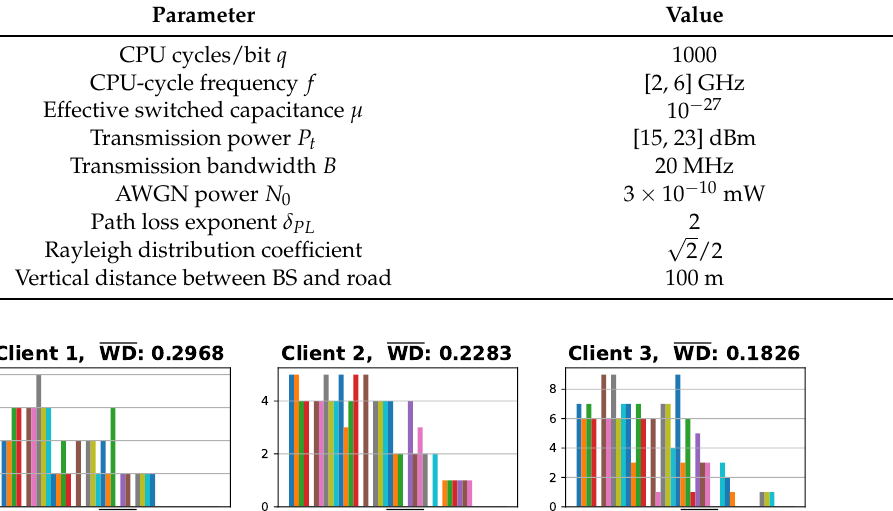
Table 2. Parameter Settings.